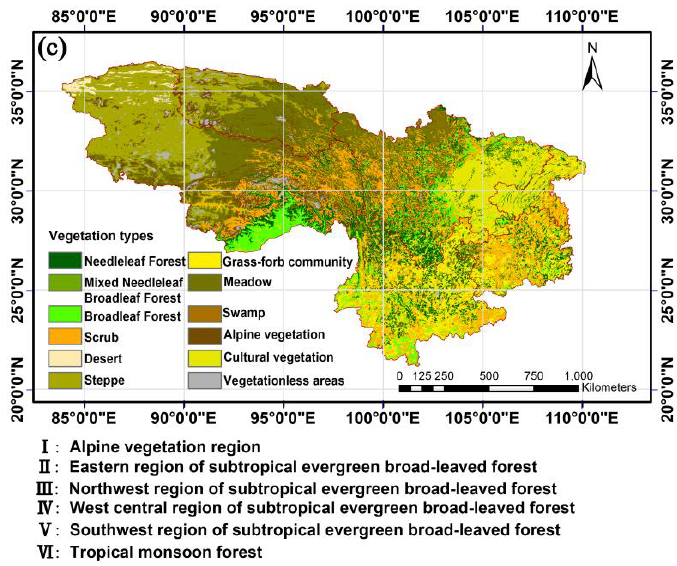
Figure 1. Outline of ( a ) geography, ( b ) vegetation divisions, and ( c ) types of vegetation in the SW area.